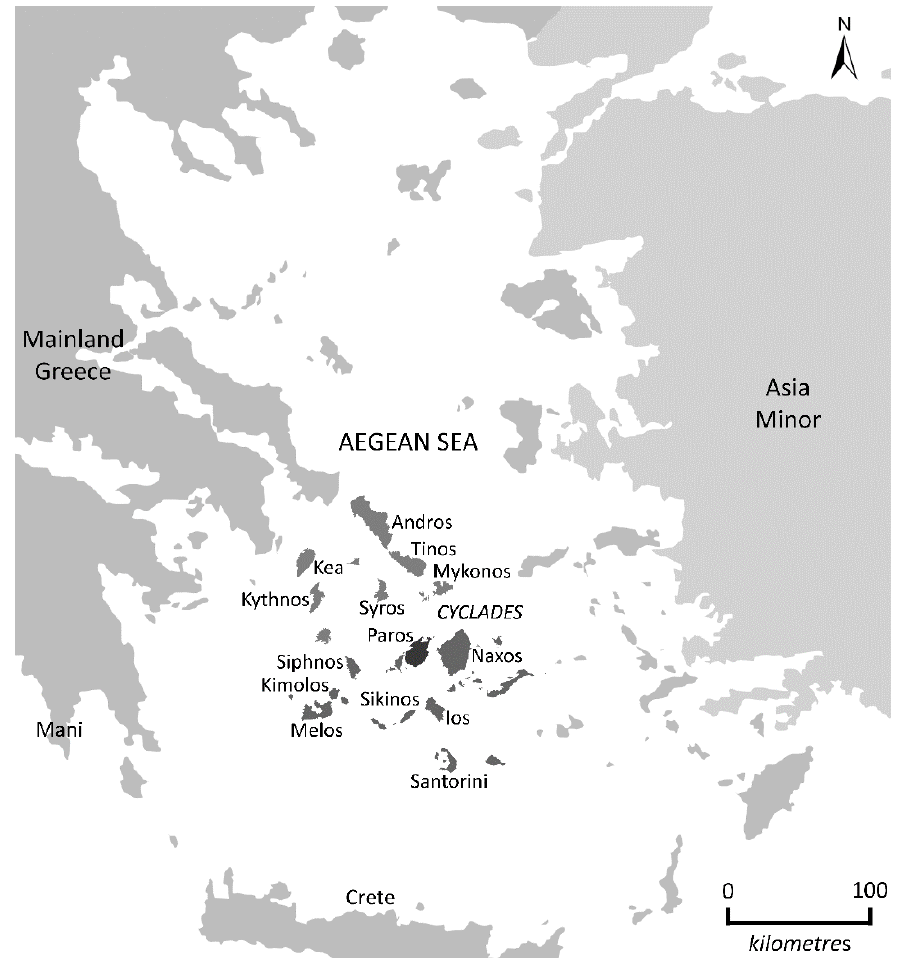
Figure 1. The Aegean, the Cyclades, and other locations mentioned in the text (map by the